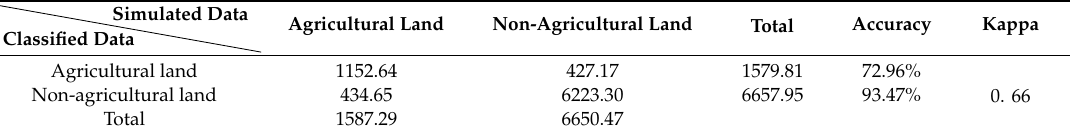
Table 9. Kappa coe ffi cient of agricultural land in 2013 (unit: km 2 ).